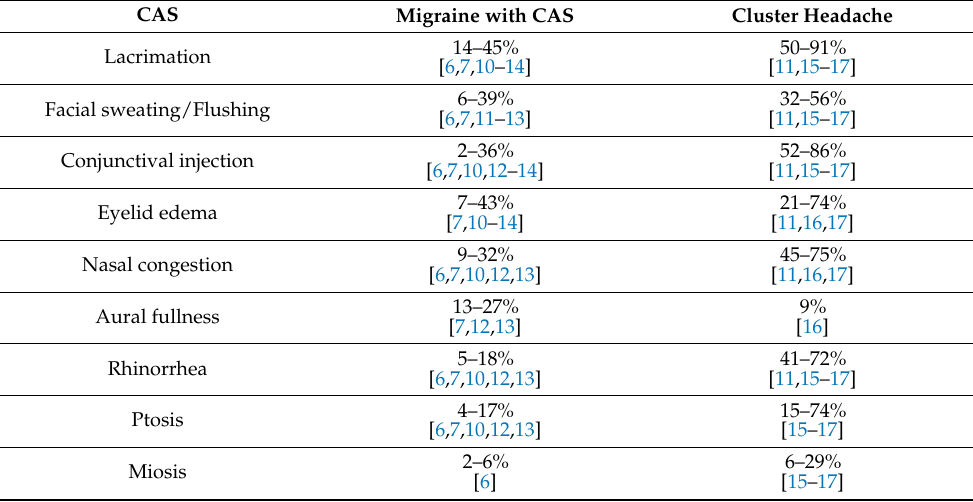
Table 1. Prevalence of cranial autonomic symptoms (CAS) in patients with migraine with CAS and cluster